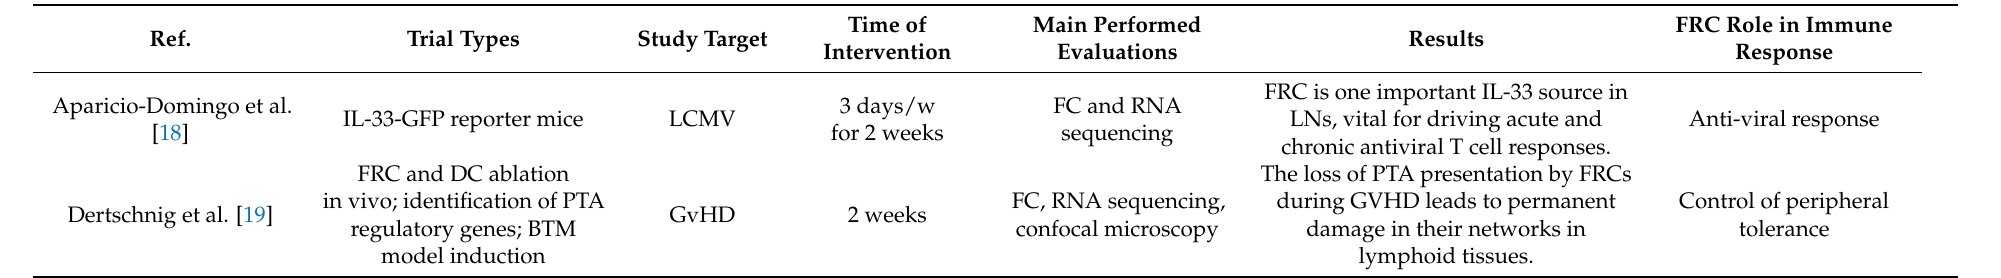
Table 4. Main characteristics of the studies used to assess the influence of fibroblastic reticular cells on the activation, expansion, or suppression of immune responses.